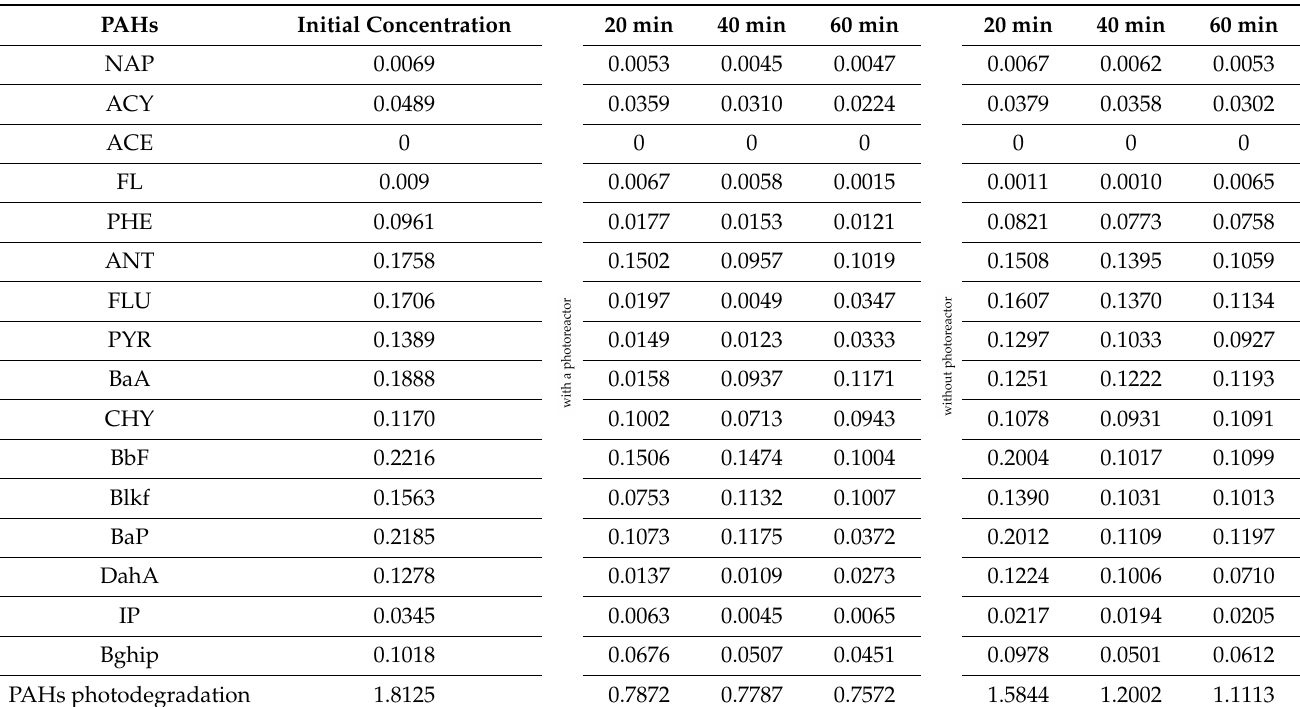
Table 5. Photodegradation of PAHs in sewage wastewater (concentrations in